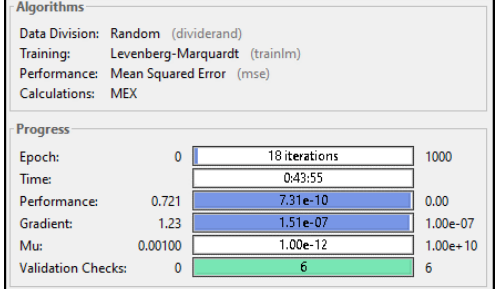
Figure 11. Algorithm used in NET1_HF neural network and data regarding the learning